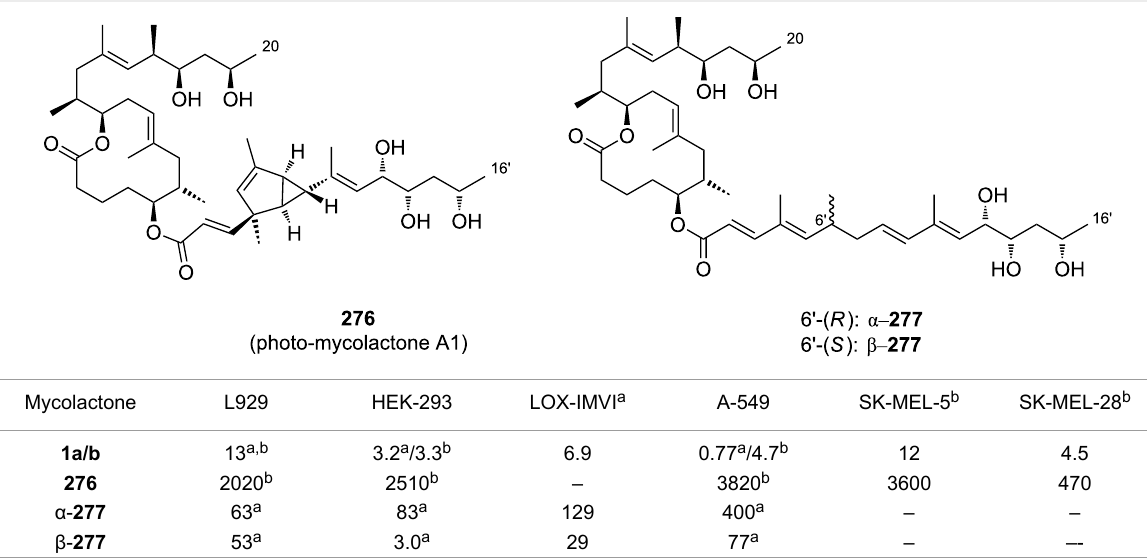
Table 1: Antiproliferative activities of photo-mycolactone A1 and C6’–C7’ dihydromycolactones (IC 50 or GI 50 values